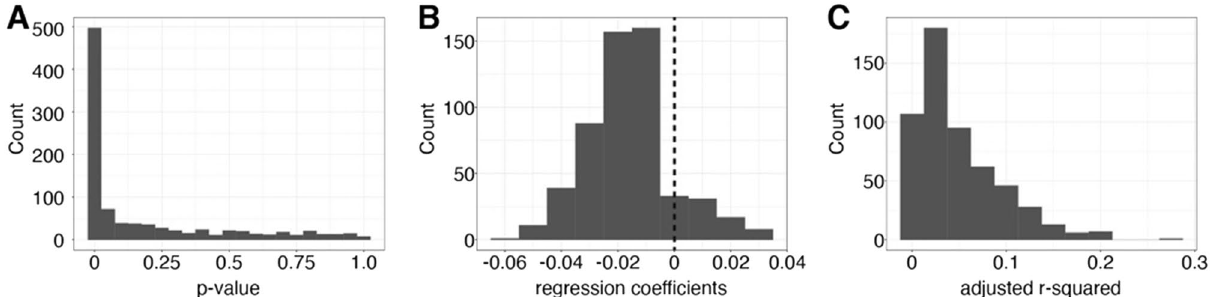
Figure 2. Transcriptional profiles of immune cells remain consistent across age groups. ( A ) Histogram of the distribution of p -values obtained from linear regression tests between age and expression level for all enriched markers of immune cell types. Bin with is 0.05. ( B ) Histogram of the distribution of beta-coefficients for the effect of age on expression level for all enriched markers of immune cell types that had a significant relationship between expression level and age. ( C ) Histogram of the distribution of adjusted r-squared value for the percent of expression variation explained by age for all enriched markers of immune cell types that had a significant relationship between expression level and